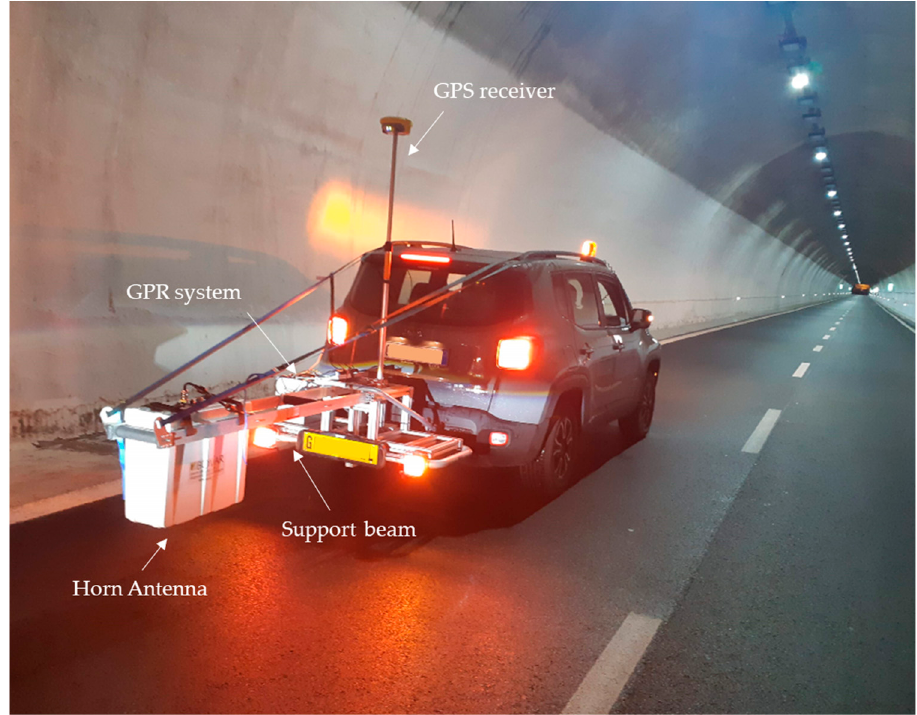
Figure 5. The acquisition setup used for ground penetrating radar (GPR) surveys. Table 1. GPR acquisition parameters.